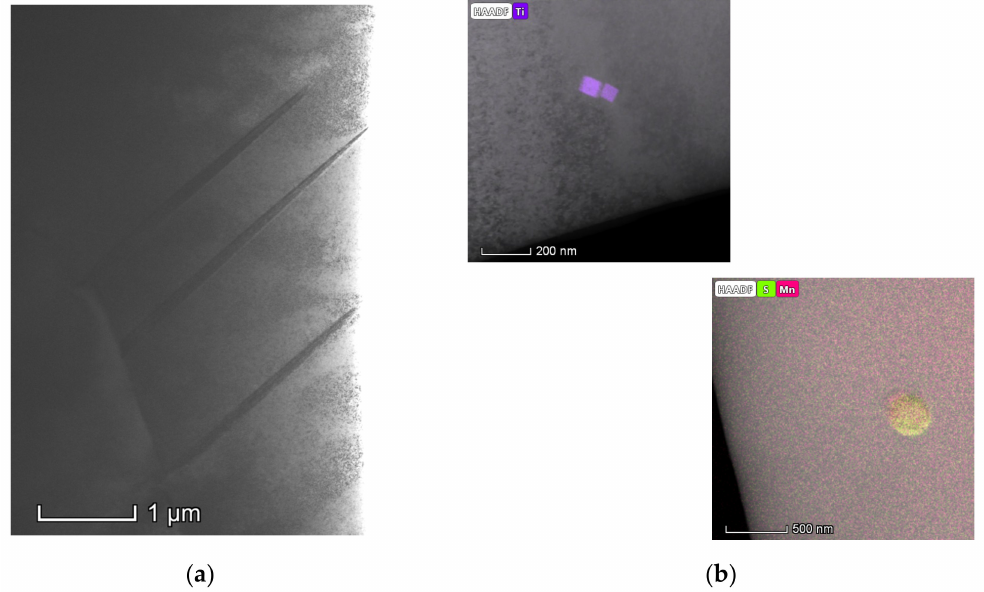
Figure 14. ( a ) TEM bright field image of cold-work deformation-induced bands in the 65 dpa material; ( b ) examples of some relatively large second phase particles, as blocky Ti-rich cuboids and a more globular Mn and S rich